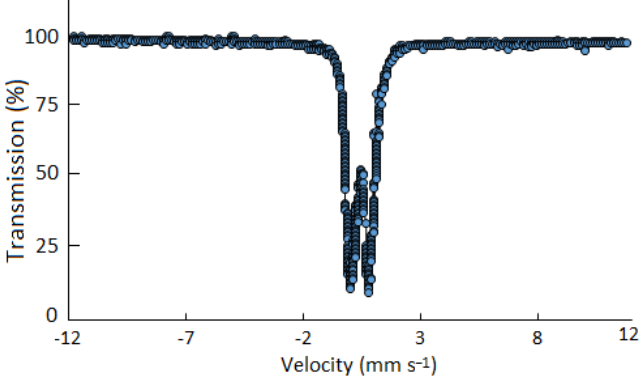
Figure 5. Mössbauer spectrum of Fe(III)–rhamnoxylan complex at room temperature (25 °C).